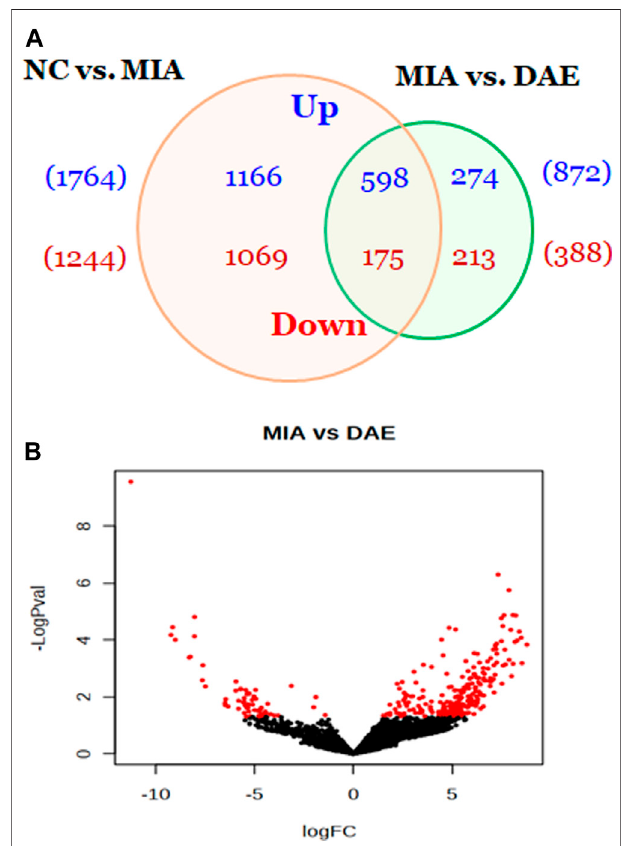
FIGURE 4 | Overview of genes affected by Dipsacus asperoides ethanolic extract (DAE) treatment. (A) Venn diagram showing the number of up- and downregulated genes in comparisons of saline- vs. MIA-treated rats and MIA- vs. MIA + DAE-treated groups. Genes with fold changes > 2 and a p -value < 0.05werecounted. (B) Volcano plotofdifferentially expressed genes in MIA- vs. MIA + DAE-treated groups. NC, rats given saline (vehicle); MIA, rats injected with MIA; MIA + DAE, rats injected with MIA and given